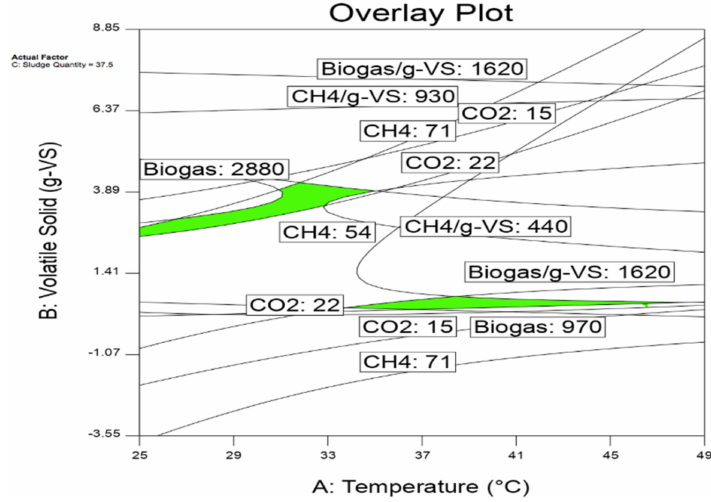
Figure 45. The first criterion overlay figure for extracted oil date seed.